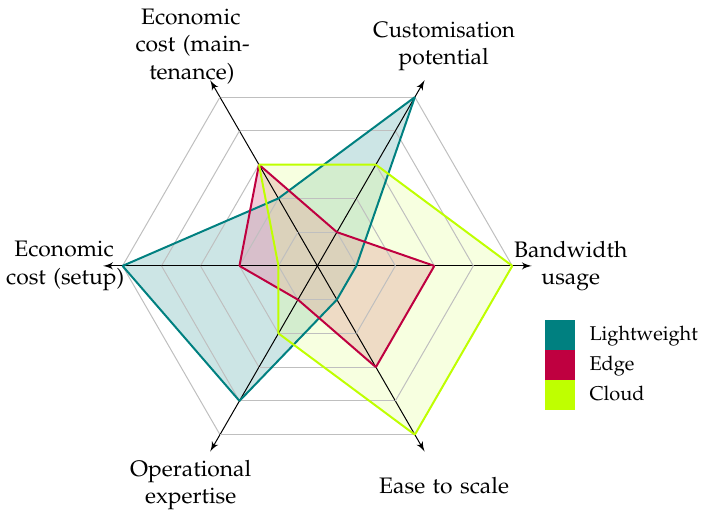
Figure 3. Comparison across deployment